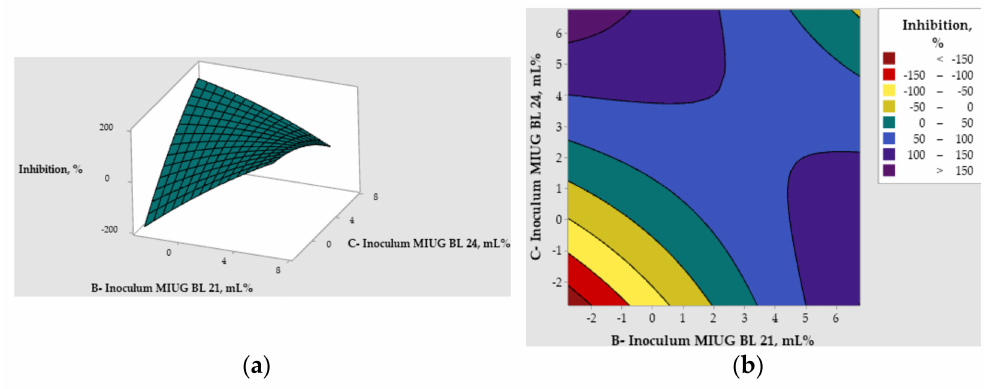
Figure 4. Surface ( a ) and contour ( b ) plots for the two-way interactions between the significant fermentation variables B and C , on the antibacterial activity (inhibition ratio, %) against Bacillus spp. The mean of the factors A to F is given in Table 2.